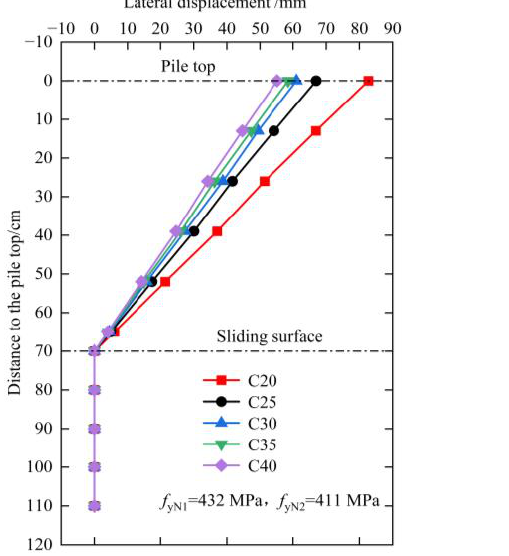
( b ) Figure 25. Variations of the pile displacement and bending moment with respect to steel bars’ strength. ( a ) Pile displacement; ( b ) pile bending moment.